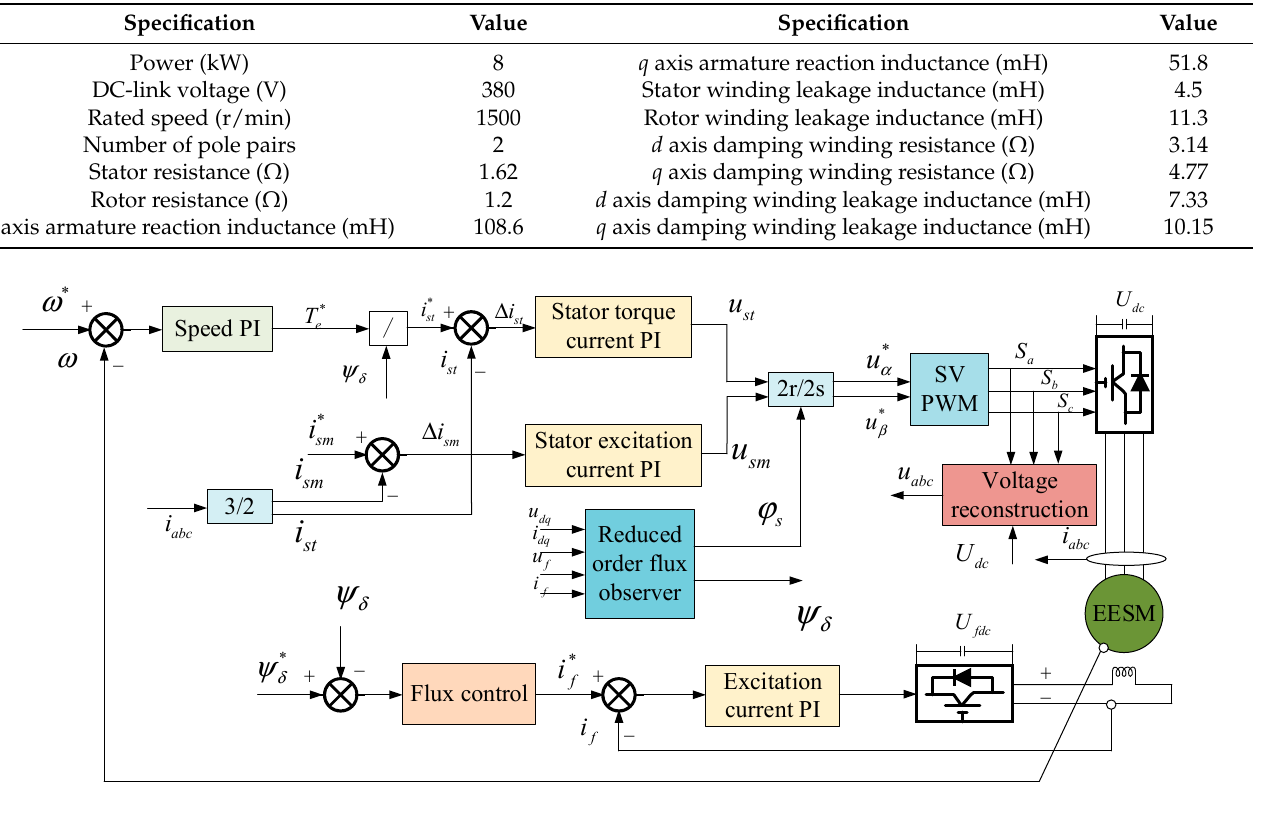
Figure 12. Diagram of air gap flux-oriented vector control system for EESM.